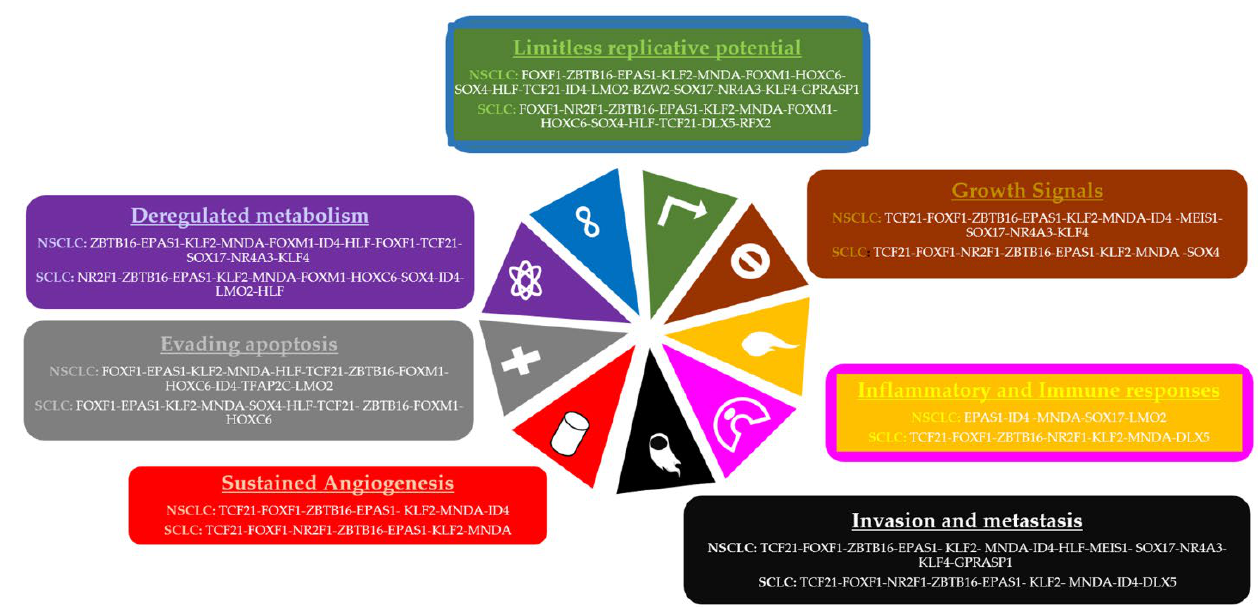
Figure 5. Most frequently dysregulated transcription factor networks related to the acquisition of the hallmarks of cancer [26] in non-small-cell lung cancer (NSCLC) and small-cell lung cancer (SCLC).